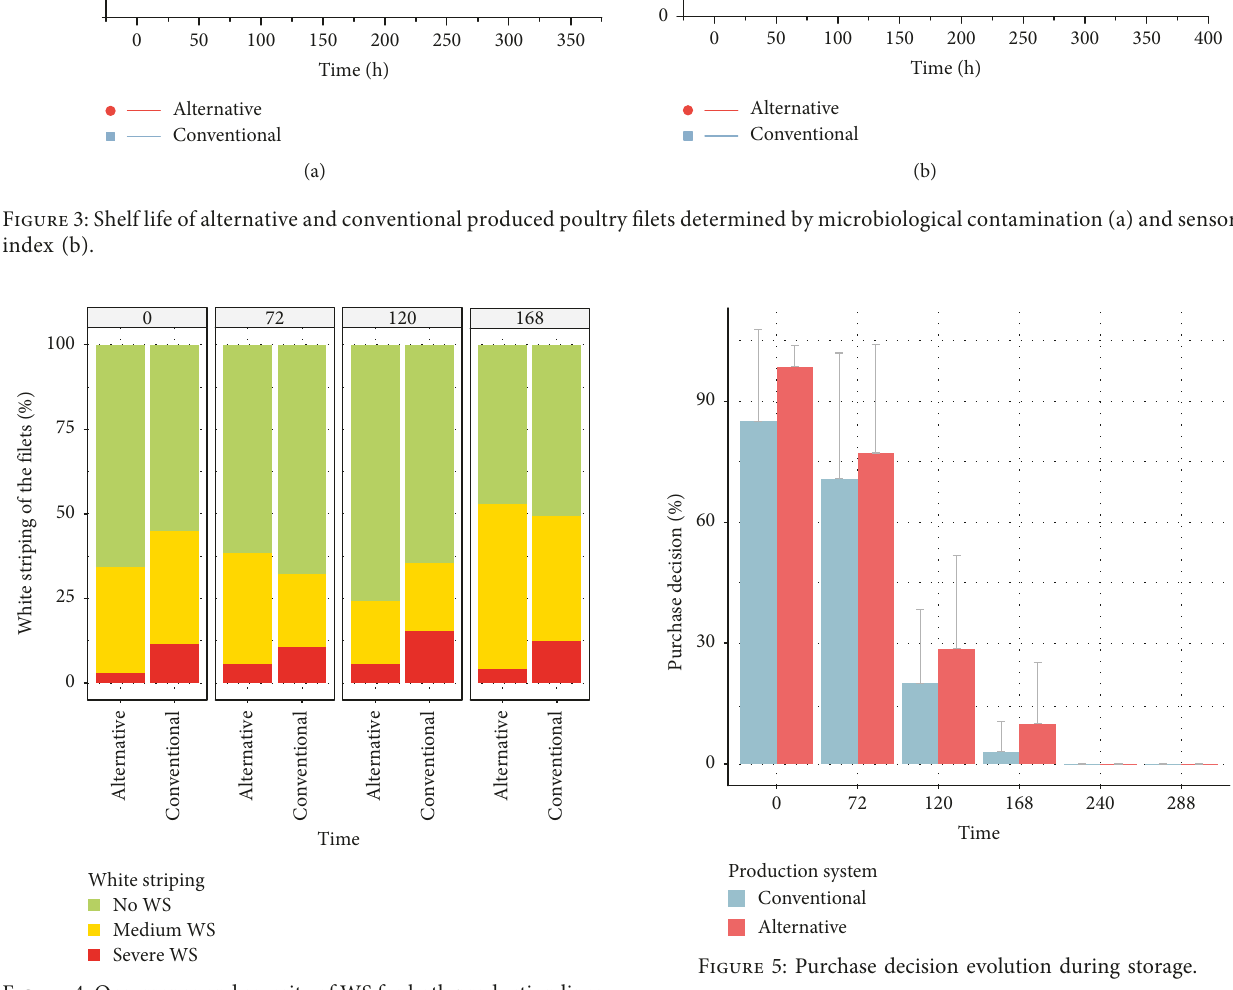
Figure 4: Occurrence and severity of WS for both production lines during storage.